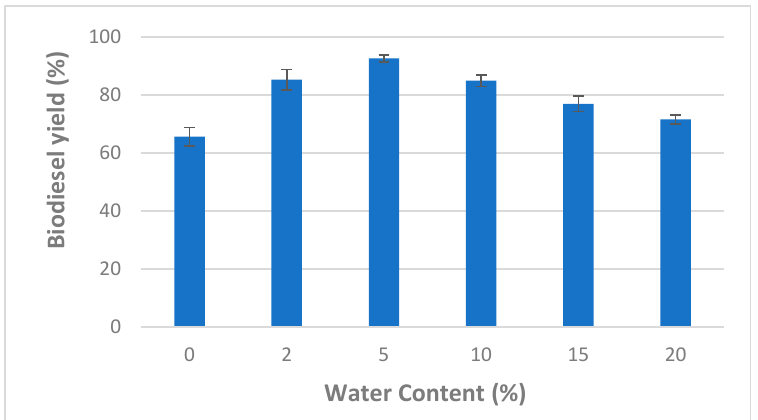
Figure 3. Effect of water content on mixed CaCO 3 -immobilized-lipase catalyzed transesterification process of waste cooking oil (WCO) for biodiesel synthesis. Experimental conditions were: methanol/oil molar ratio: 6:1, lipase loading 1%, reaction temperature: 45 °C, reaction time 24 h, agitation speed 150 rpm. Experiments were performed in triplicate and error bars indicate mean ± standard deviation.